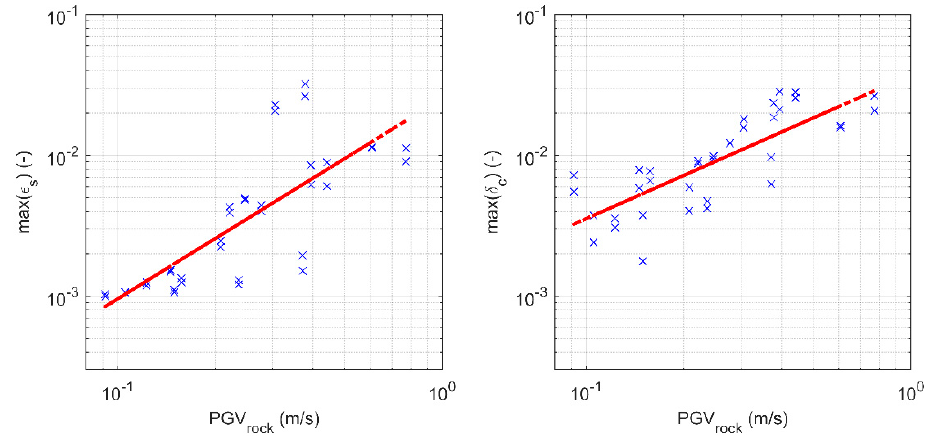
Figure 8. Left: Reinforcement strain ( ε s ). Right: Crane drift ( δ c ) to PGV rock . Plots created without using any scaling factor in the input motions.